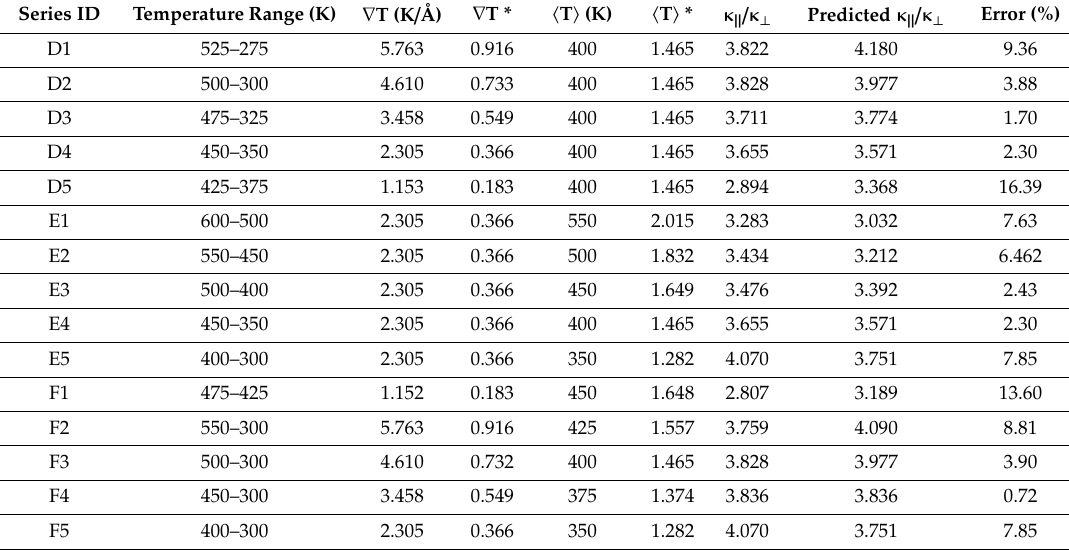
Table 2. Results for water confined by “hydrophilic” (artificially charged copper) walls for a range of temperatures and temperature